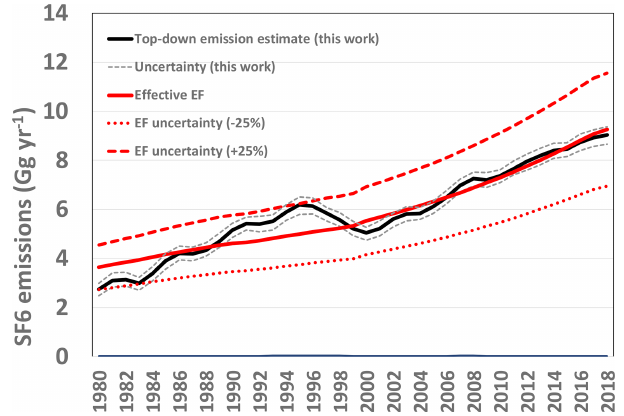
Figure 9. Top-down emission estimate (solid black line) with 1 σ uncertainties and a bottom-up estimate, based on SF 6 prompt emis- sions plus an emissions estimate from the electrical power industry (FF = 52tGW − 1 ) and an inferred effective EF (2.5%) with ± 25% uncertainty (dashed